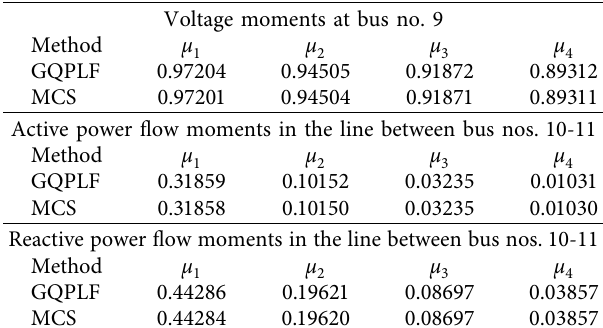
Table 1: Statistical moments of output variables.